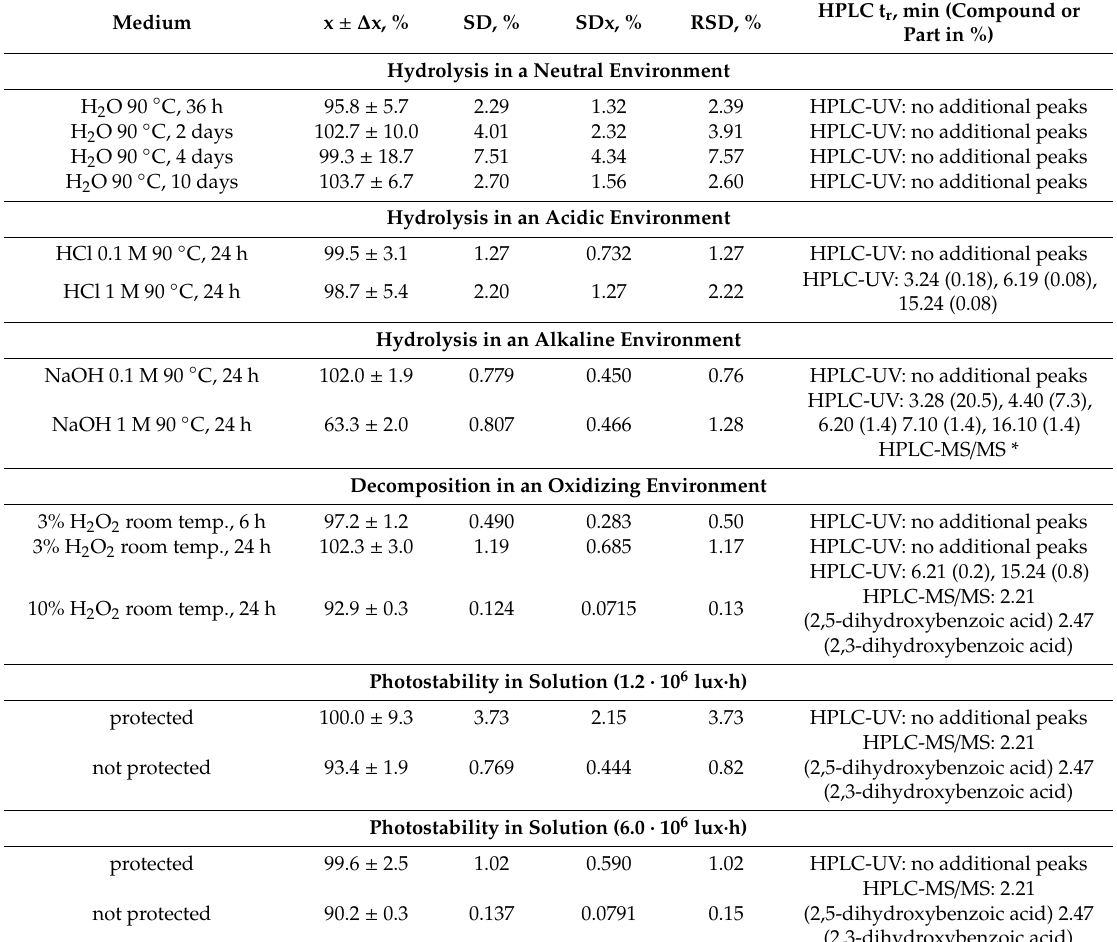
Table 5. The content of the CS in solutions after hydrolysis and oxidation, calculated in relation to the declared value and the retention times of the observed degradation products designated by HPLC